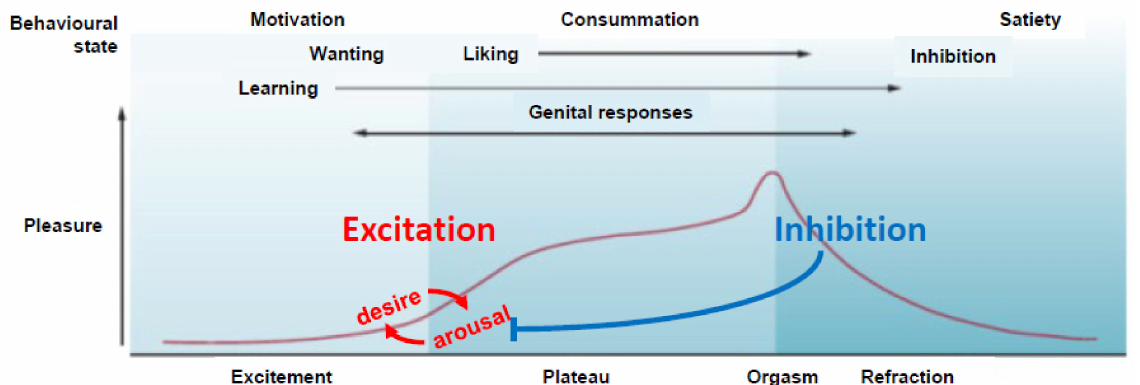
Figure 1. Depiction of Masters’ and Johnson’s “EPOR” model of human sexual response and related the activation of corresponding excitatory (red) and inhibitory (blue) brain regions. Opioid and serotonergic transmissions at orgasm activate inhibitory feedback on mechanisms of sexual arousal and desire. Adapted with permission from Georgiadis, Kringelbach, and Pfaus [14] (2012. Nature Publishing